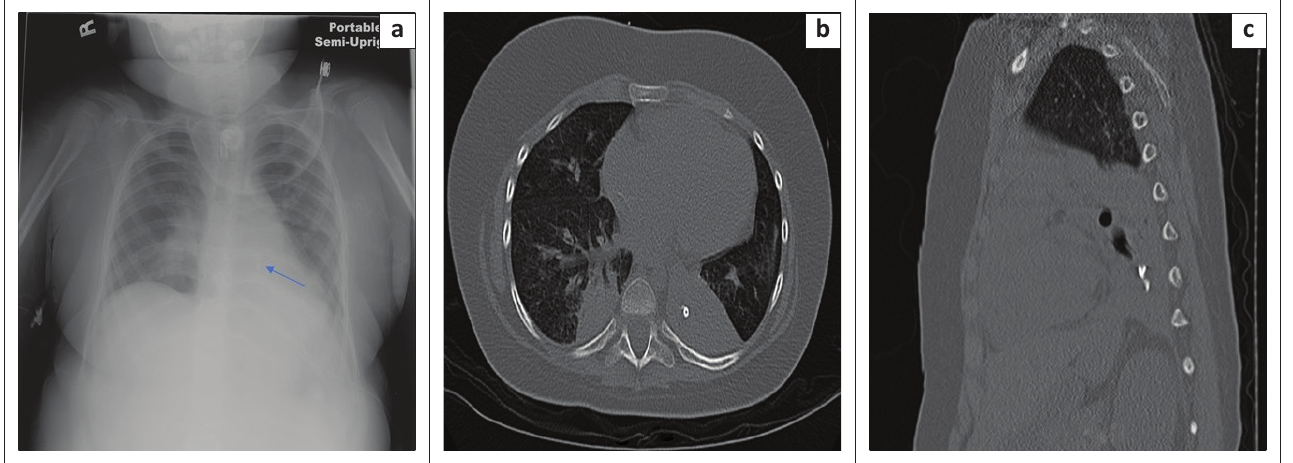
FIGURE 16: Images of a 6-year-old child with severe anoxic encephalopathy who presented with a history of teeth aspiration. The aspirated teeth are barely visible (arrow) on the chest radiograph (a). Multi-detector computed tomography axial (b) and sagittal reformatted (c) images confirmed the location of the aspirated teeth in the left lower lobe